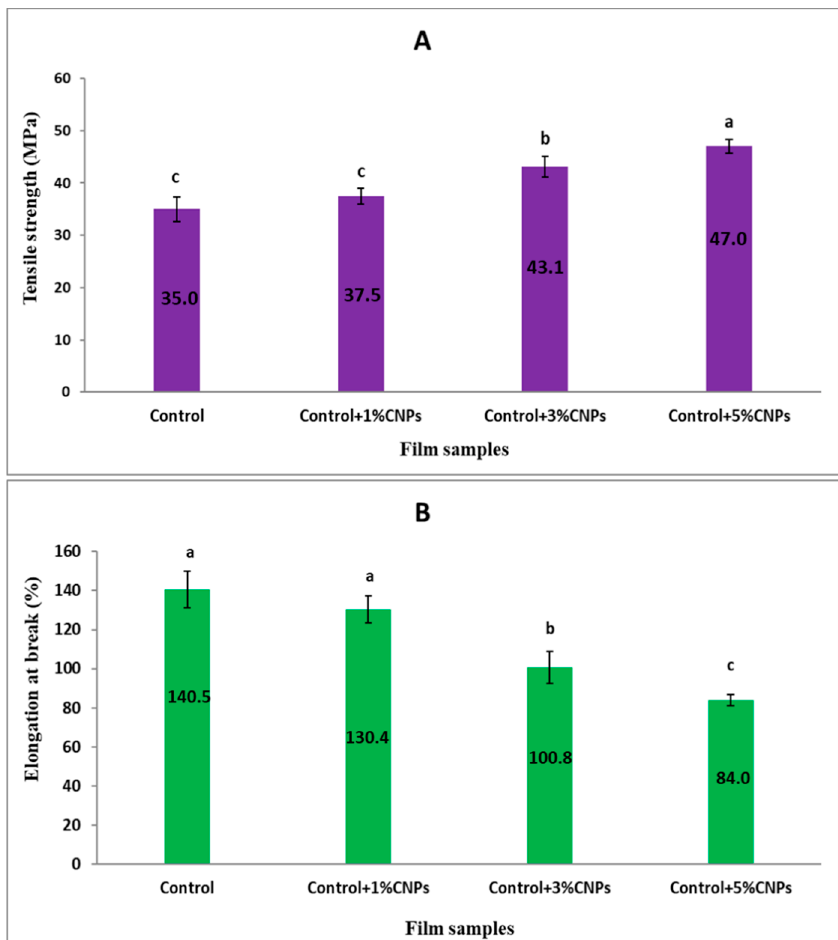
Figure 4. ( A ) Tensile strength and ( B ) elongation at break of neat and CNP-loaded starch-PVA films. Starch-PVA 40:60 (control film sample), starch-PVA loaded with 1% CNPs (control + 1% CNPs), starch-PVA film loaded with 3% CNPs (control + 3% CNPs), and starch-PVA film loaded with 5% CNPs (control + 5% CNPs). Different letters in each diagram indicate statistically significant differences at p < 0.05.